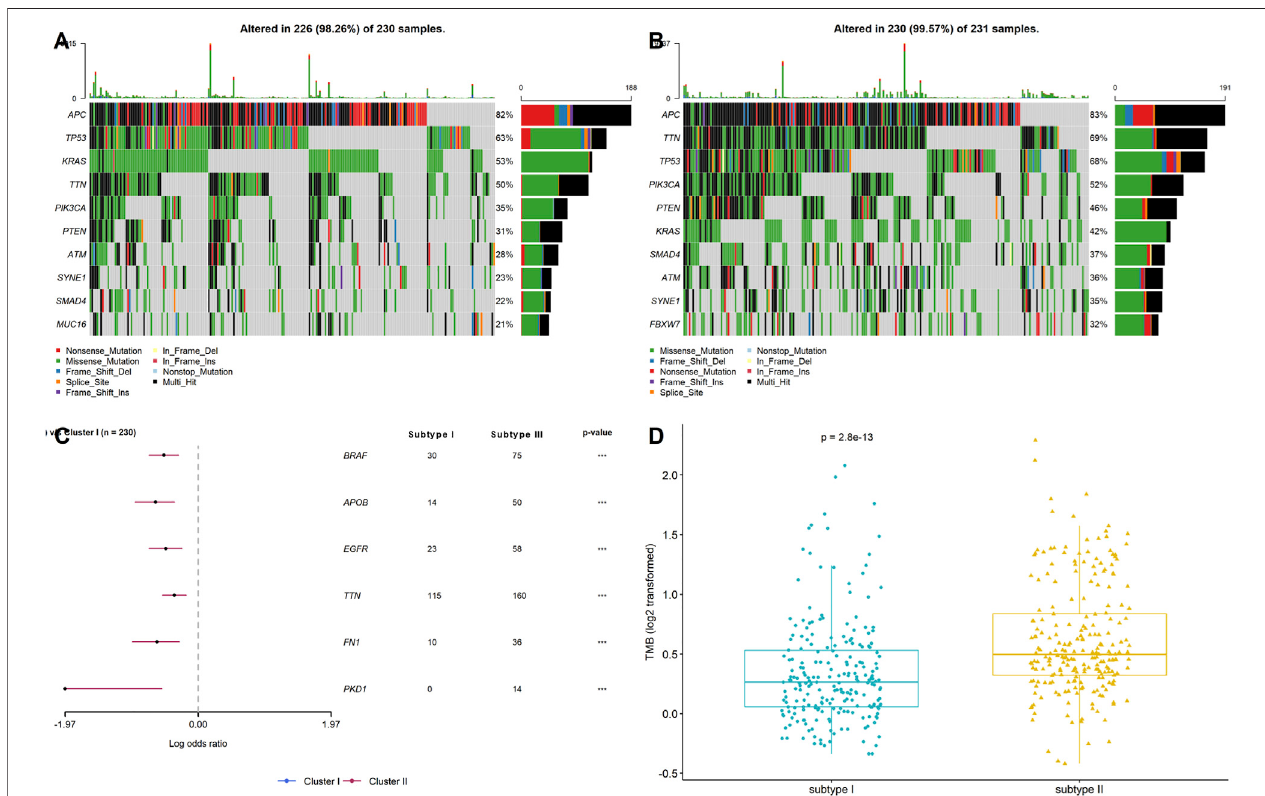
FIGURE 4 | Stemness subtypes possessed different TMB. Waterfall plots showed the top 10 mutated in (A) stemness subtype I and (B) stemness subtype II; (C) Forest plot exhibited the signi fi cant mutated genes between the two stemness subtypes; (D) The comparisons of TMB between stemness subtype I and stemness subtype